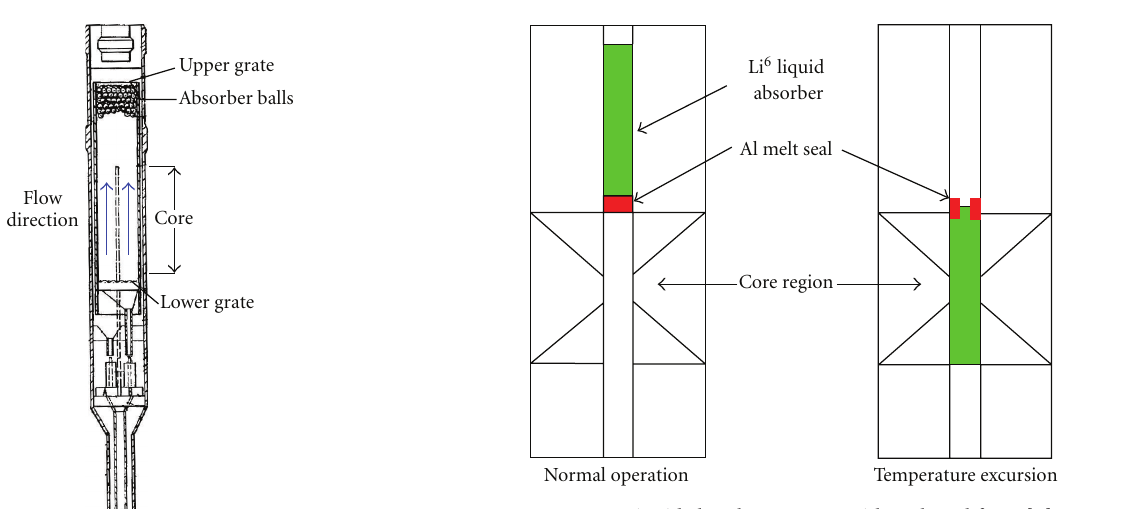
Figure 2: Liquid absorber concept with melt seal from